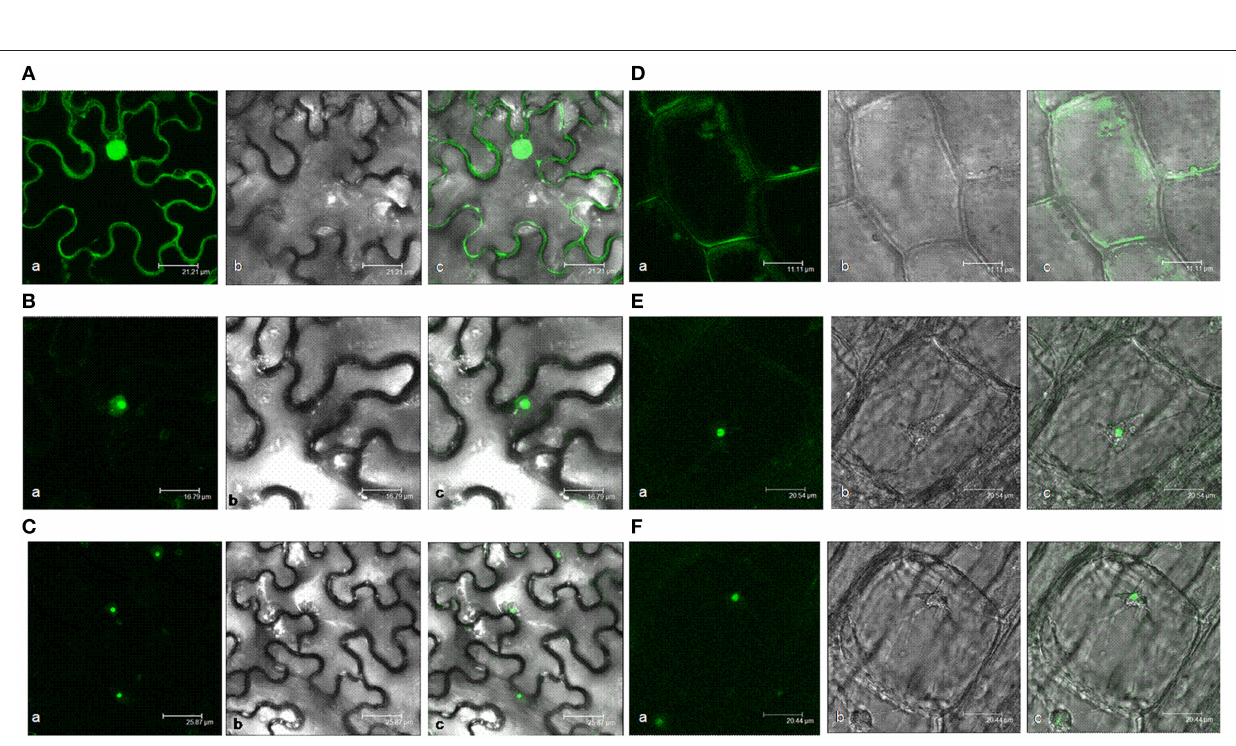
Frontiers in Plant Science |